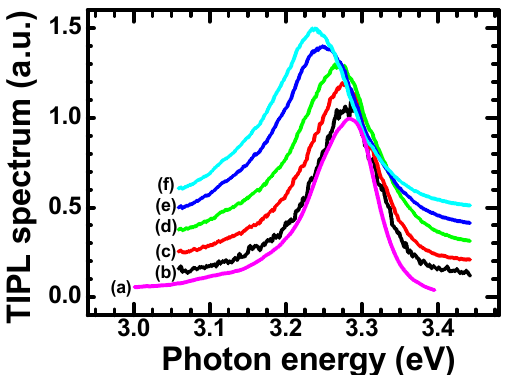
Figure 1. Time-integrated PL spectra measured at different laser fluencies. Curve ( a ): low-fluence CW excitation (HeCd laser). Curves from ( b ) to ( f ) are obtained using the pulsed laser excitation and at optical excitation fluencies of 10, 50, 276, 1190 and 1940 μ J cm − 2 for curves from ( b ) to ( f ), respectively. Please note that the curves are vertically shifted to improve the figure readability.